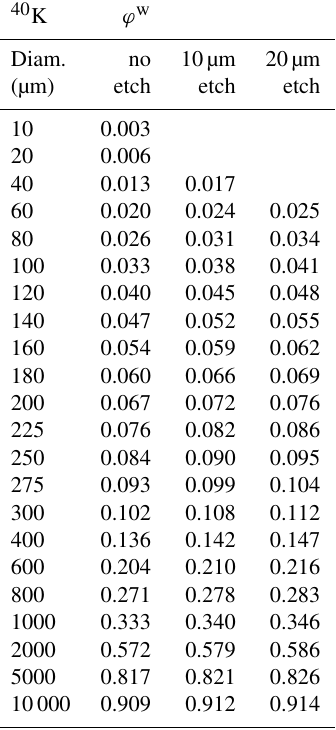
Table 3. Potassium feldspar self-dose values for whole-grain sources, ϕ w , for 40 K sources